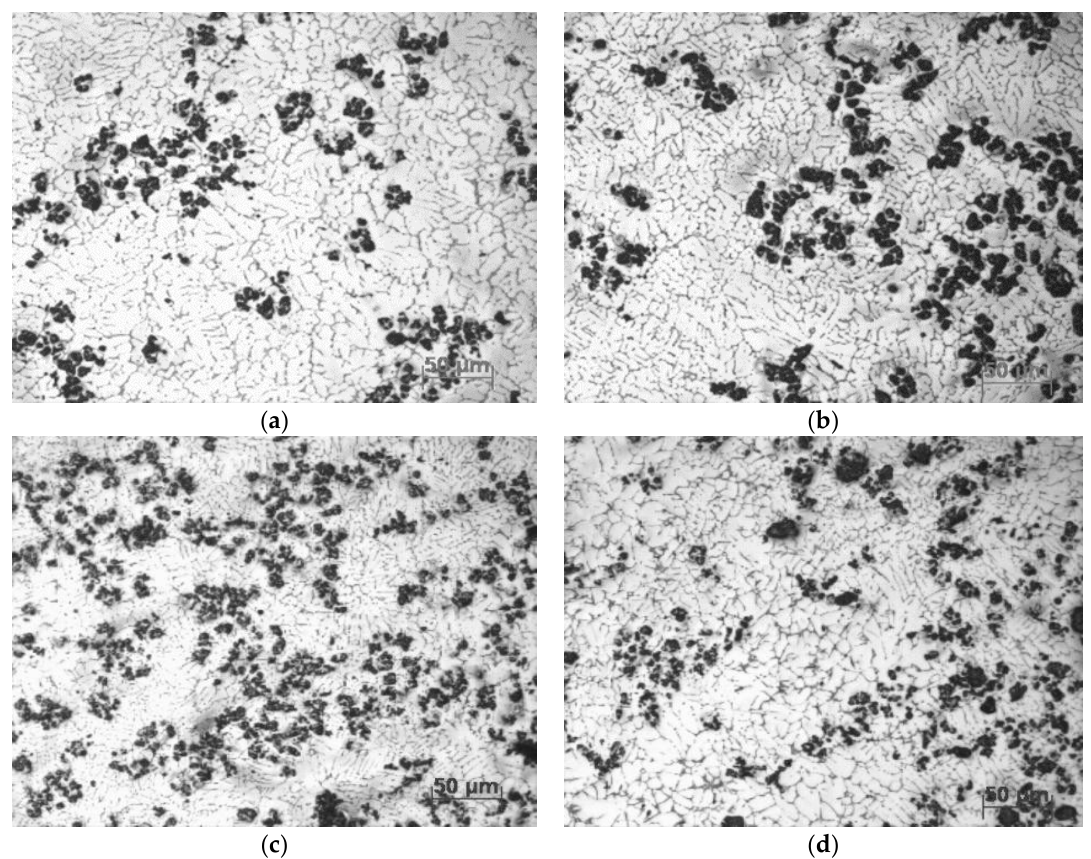
Figure 3. The optical microstructure of Al ‐ 2.5%TiB 2 for ( a ) holding time of 20 min, ( b ) holding time of 50 min and Al ‐ 5%TiB 2 for ( c ) holding time of 20 min, ( d ) holding time of 50 min.